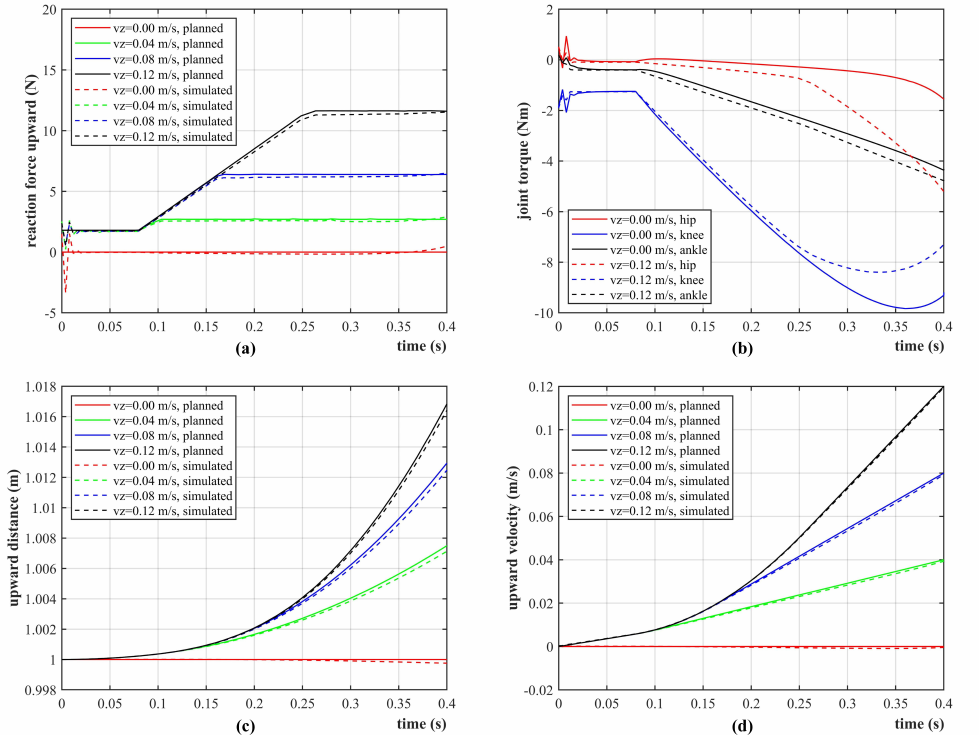
Figure 9. Motion planning and control of the PFP locomotion targeted at various oblique free-flying velocities. ( a ) reaction forces in the upward direction. ( b ) joint torques. ( c ) COM positions in the upward direction. ( d ) upward